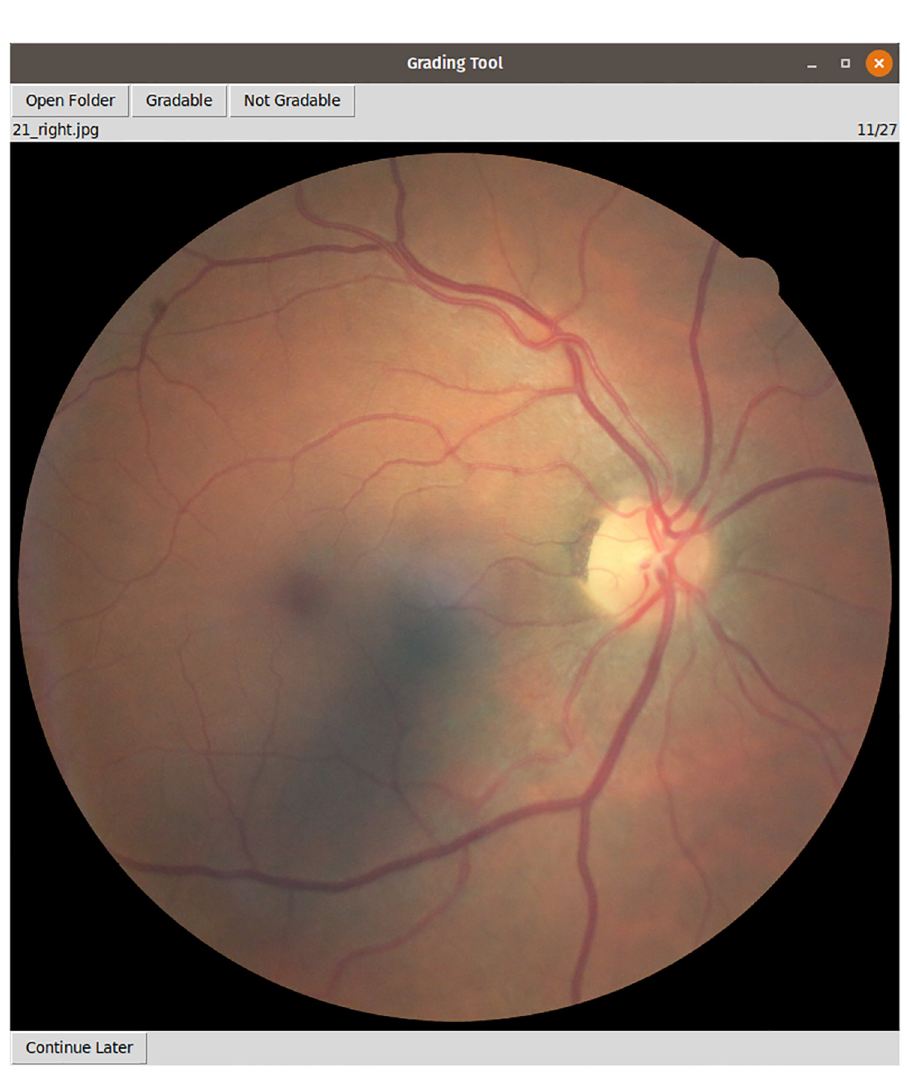
Fig 2. Grading tool. Screenshot of grading tool used to assess gradability for all